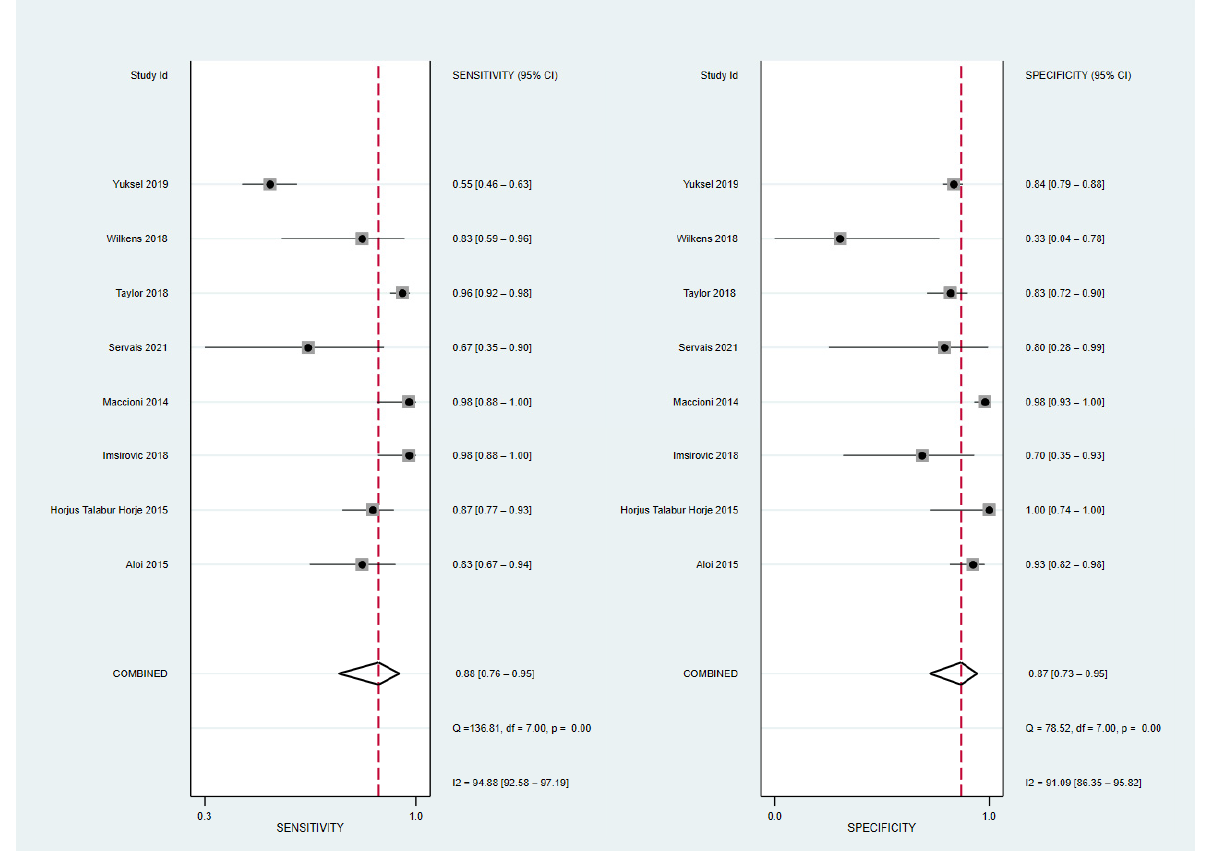
Figure 4. Coupled forest plots of the overall pooled sensitivity and specificity for diagnosing active bowel lesions in patients with Crohn’s disease using MR enterography. MR, magnetic resonance [18,21–27].